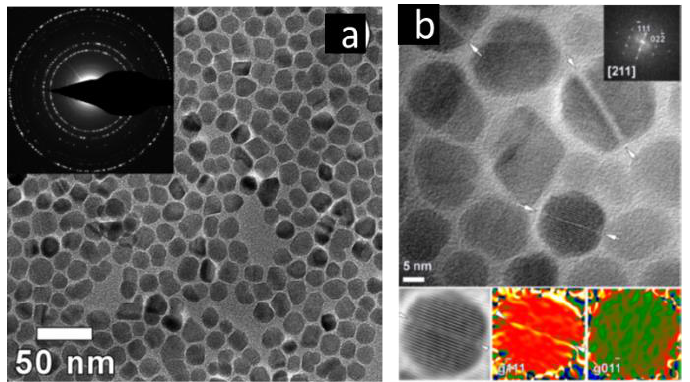
Figure 8. Fe 3 O 4 @OA coated NPs developed by hydrothermal method. ( a ) Low-resolution bright-field TEM images and corresponding ED ring patterns and ( b ) representative HRTEM image together with Fourier Transform FT pattern (inset). White arrows mark the dimer boundaries. Bottom insets: a filtered HRTEM image of a selected dimer NPs ( left ) and the corresponding GPA images for g1 ̅ 11 ( middle ) and g011 ̅ ( right ) diffraction spots. (Figures reprinted with permission from [42], ACS, 2014.